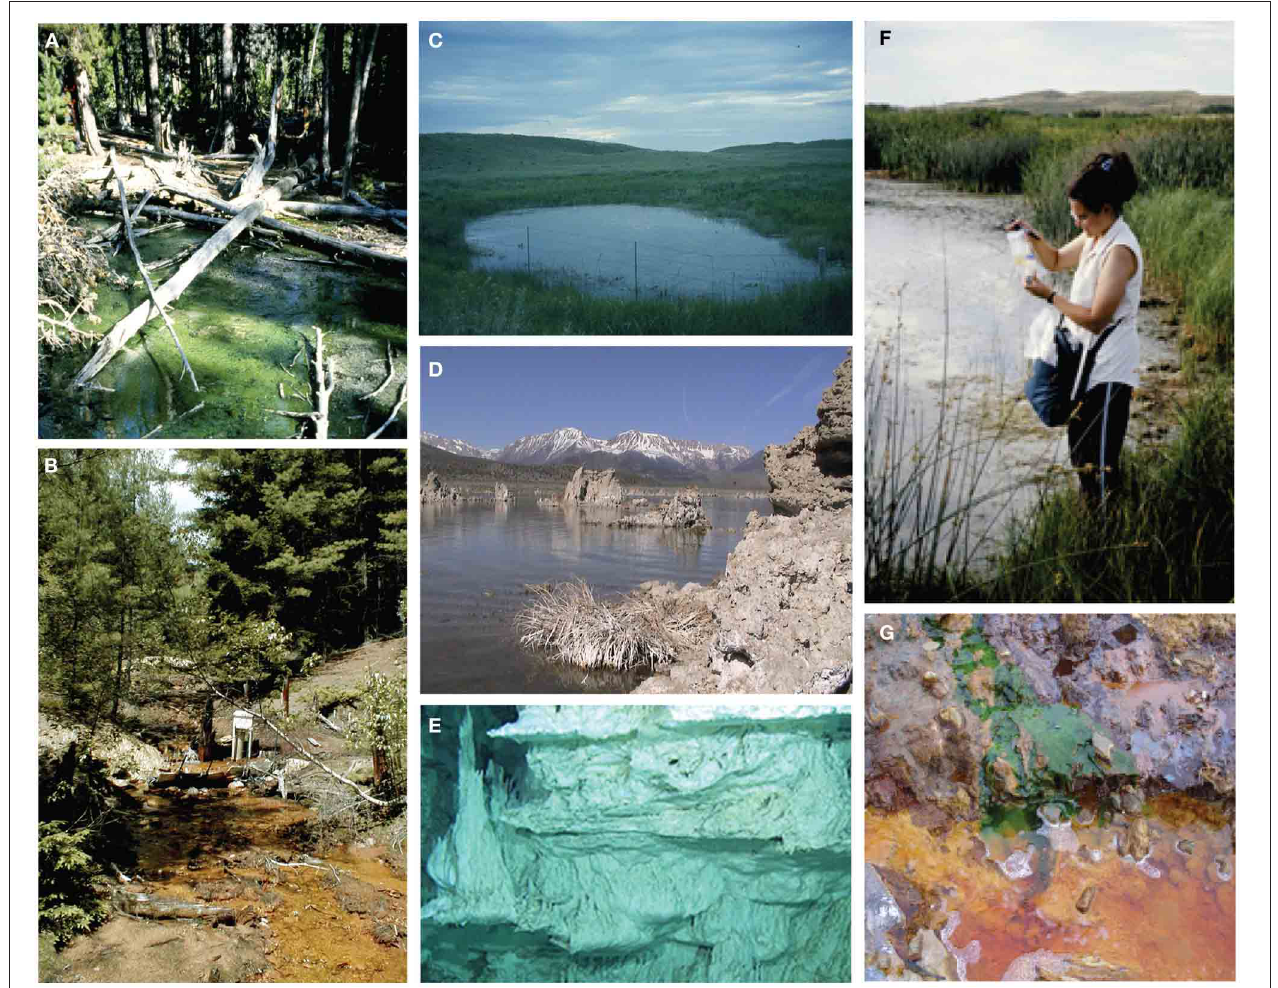
FIGURE 1 | pH extreme sites examined in this study. (A) Nymph Creek, Yellowstone National Park (YNP), WY, USA. (B) Davis Mine, Rowe, MA, USA. (C) Sandhills Lake Between Tree Claim and Smith, Crescent Lake Wildlife Refuge, NE, USA. (D) South Tufa at Mono Lake, CA, USA. (E) Lost City